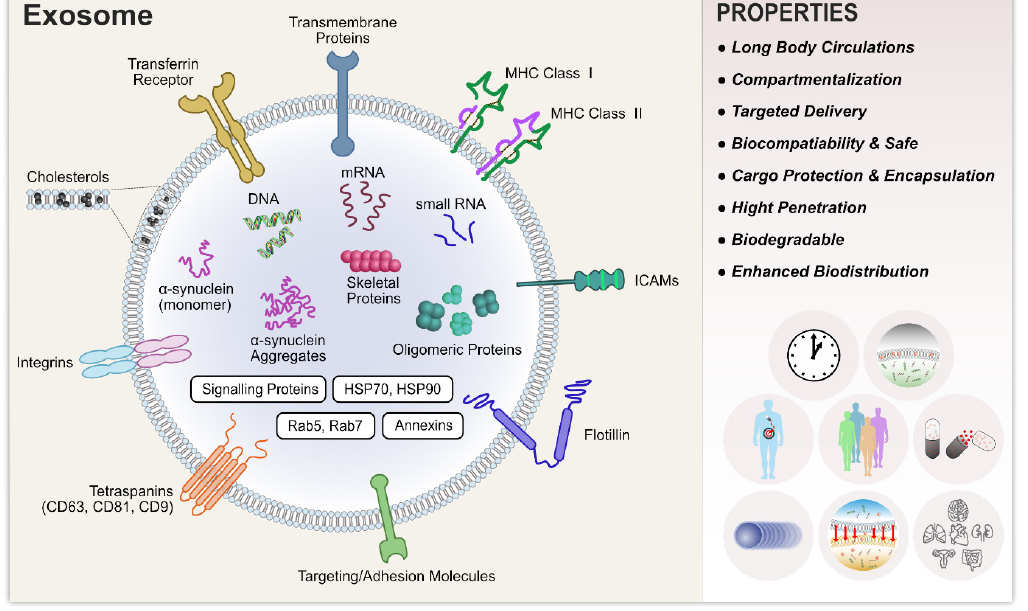
Figure 5. Typical structure of exosomes, properties, and functional attribution of various biomolecules present in exosomes.